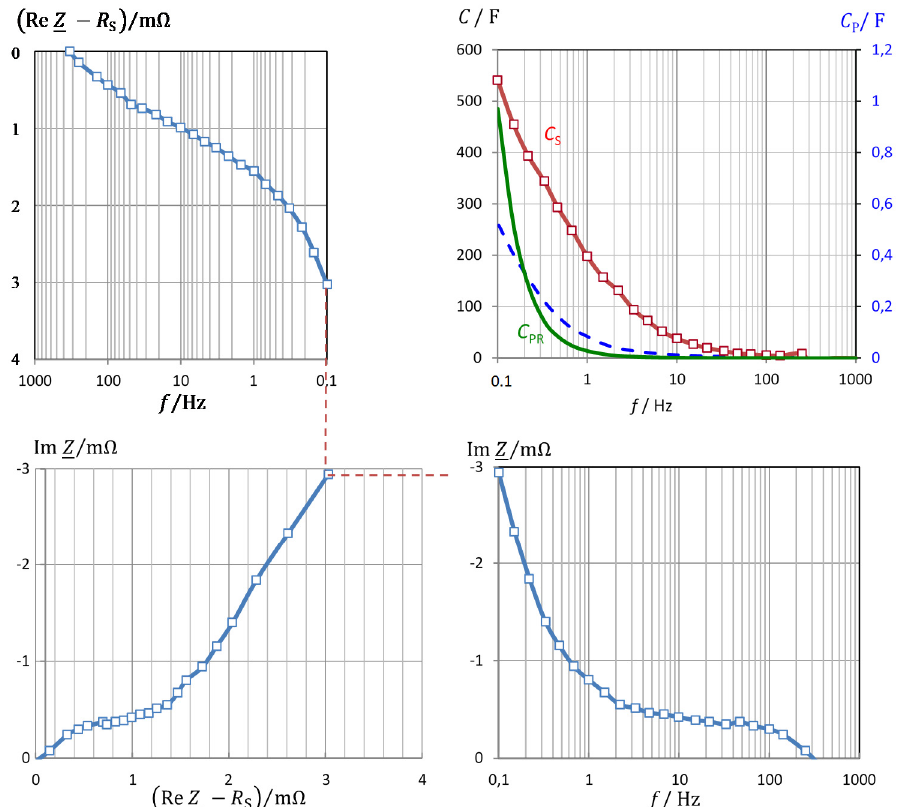
Figure 3. Frequency response of impedance of the cell C LithiumWerks (2.6 Ah) . The electrolyte resistance R S = R (333 Hz) was subtracted. Capacitance versus frequency: 𝐶 (cid:2903) = −1 (𝜔𝑋)⁄ , including leakage: 𝐶 (cid:2900) = −𝑋 (cid:4670)𝜔(𝑅 (cid:2870) + 𝑋 (cid:2870) )(cid:4671)⁄ , and corrected by the electrolyte resistance: 𝐶 (cid:2900)(cid:2902) = −𝑋 (cid:4670)𝜔((𝑅 − 𝑅 (cid:2903) ) (cid:2870) + 𝑋 (cid:2870) )(cid:4671)⁄ according to Equation (4). Imaginary part of impedance: X = Im Z ( ω ).